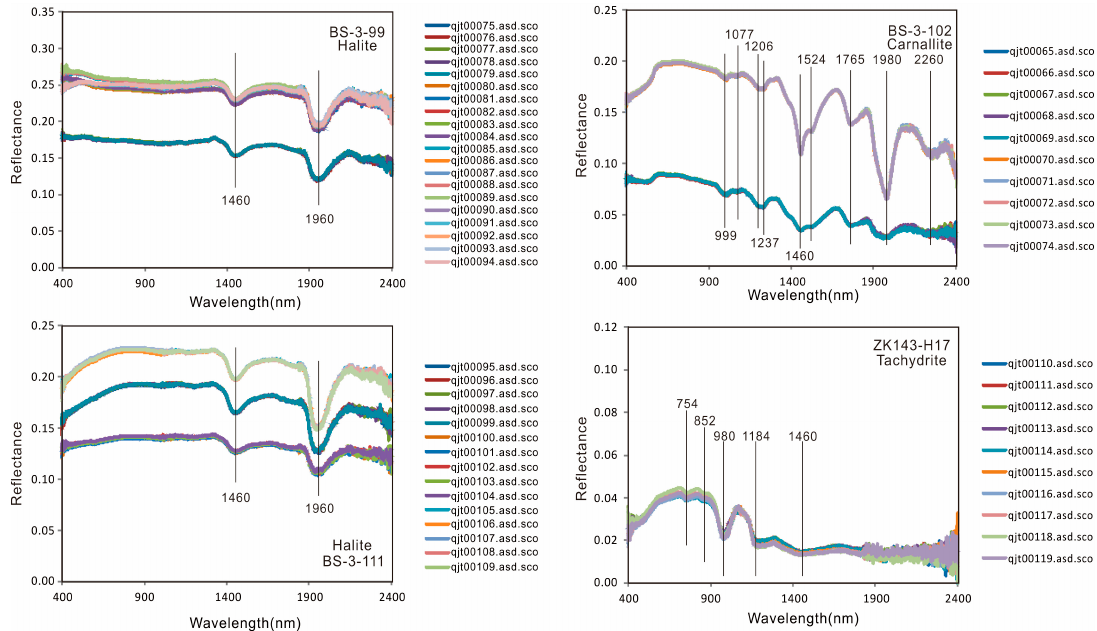
Figure 4. Spectra of eight mineral samples recorded by ASD spectrometer.